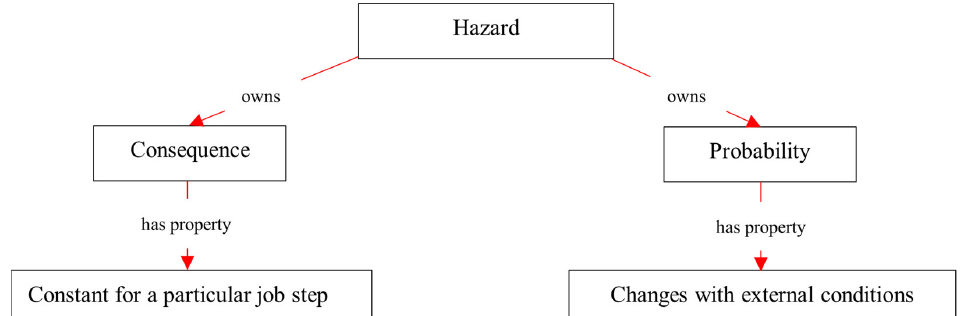
Figure 8. Risk variables of hazards.